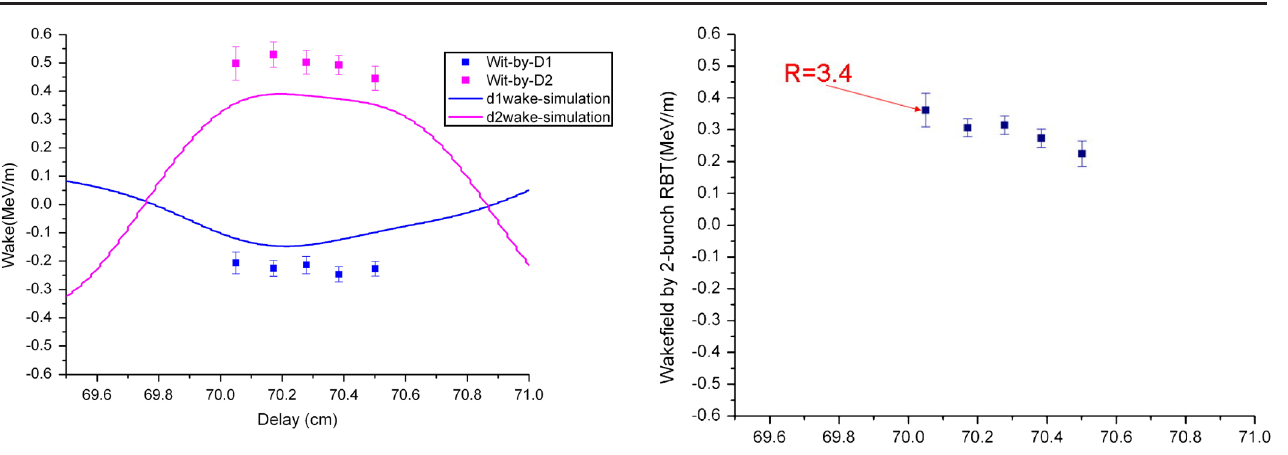
plot).FIG. 7. Wake potential per unit length due to drive bunch #1 (blue) and #2 (pink) traversing the 13.625 GHz dielectric accel- erator. In the plot, each solid square is a measurement with a mean value of 20 data samples and error bar is the standard